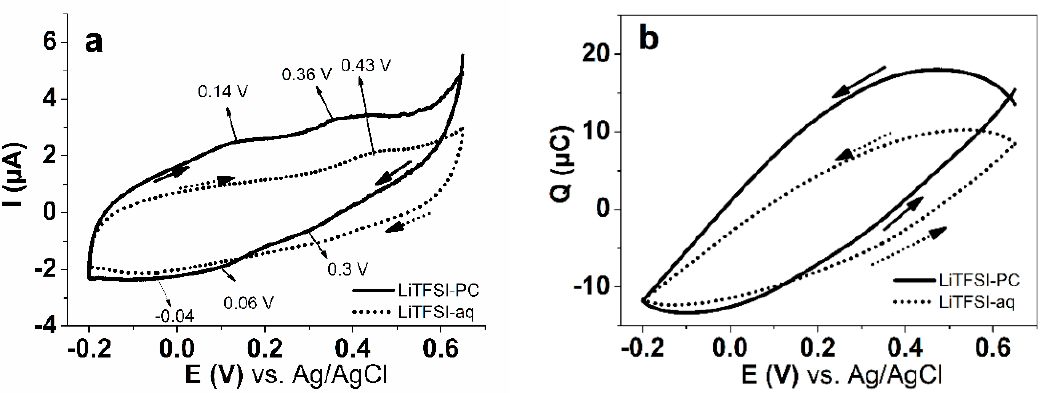
Figure 4. Cyclic voltammetry (50 mV s − 1 , 3rd cycle) with mSICM measurements of PPyPIL film surface in LiTFSI-aq (dotted) and in LiTFSI-PC (solid line) of ( a ) current I and ( b ) charge Q vs. potential E. Incidentally, the surface mSICM response was rather uniform, no domains of predominantly PPy or PIL content were identified. The shape of the CV curves measured on the surface of PPyPIL